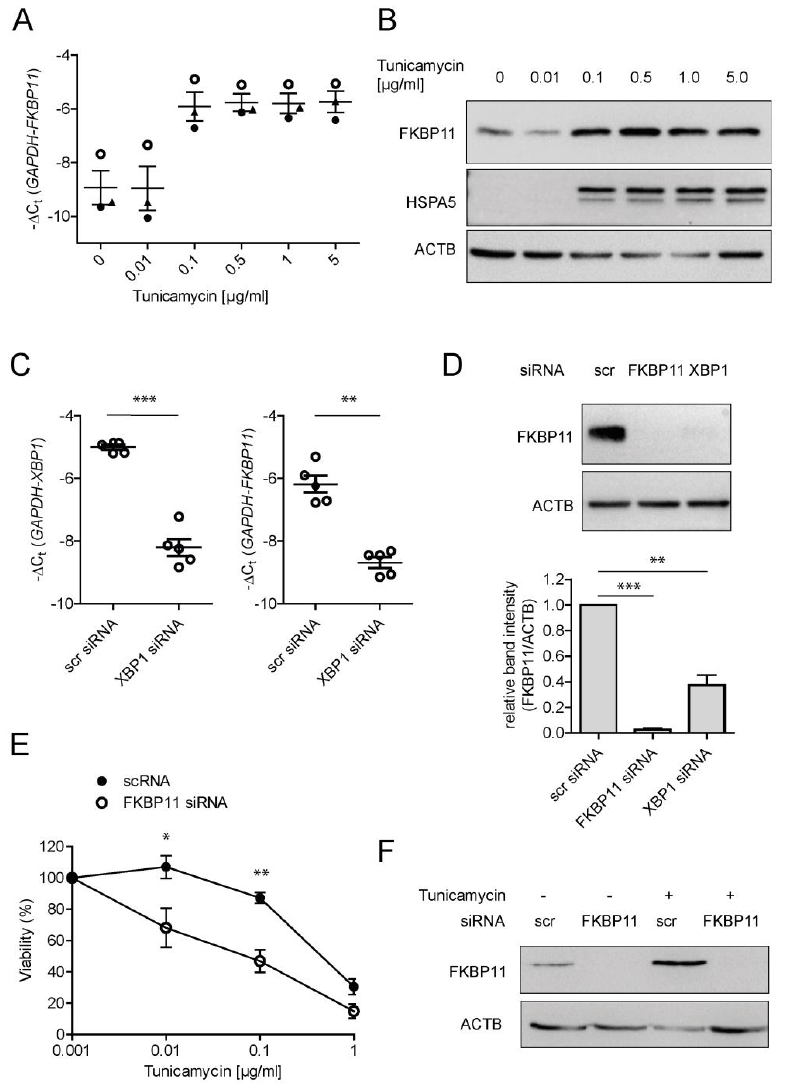
Figure 4. FKBP11 is induced by ER stress in an XBP1-dependent manner and protects from ER- stress induced cell death. ( A , B ) Treatment of A549 with the synthetic ER stress inducer tunicamycin led to a dose-dependent increase of FKBP11 expression both on transcript ( A ) and on protein level ( B ). Upregulation of the ER chaperone HSPA5 confirmed induction of ER stress. ACTB = β -actin as loading control. ( C ) Knockdown of XBP1 in A549 cells treated with 0.1 µg/mL tunicamycin was efficient as assessed by qRT-PCR (left, p = 0.0007, paired t -test) and led to a drastic decrease of FKBP11 transcript (right, p = 0.0026, paired t -test). ( D ) Knockdown of XBP1 equally led to loss of FKBP11 protein ( p = 0.0014, paired t -test). This result is shown in comparison to FKBP11 knockdown under similar conditions ( p < 0.0001, paired t -test); top panel, representative Western Blot; bottom panel corresponding densitometric analysis). ( E ) Combining FKBP11 knockdown with different concentrations of tunicamycin ranging from 1 ng/mL to 1 µ g/mL and assessing cell viability by trypan blue exclusion showed that FKBP11 knockdown leads to higher susceptibility to ER stress- induced cell death (Exact p -values: 0.01 µ g/mL: p = 0.0414; 0.1 µ g/mL: p = 0.0068; paired t -test.) ( F ) Knockdown of FKBP11 in A549 cells was highly efficient in absence and presence of tunicamycin. For ( A , E ) data shown is based on three and four independent experiments, respectively, and given as mean ± SEM. ( B , F ) is representative for three independent experiments. For ( C , D ), data shown is based on five independent experiments and given as mean ± SEM. A paired t -test was used for statistical analysis (* p < 0.05; ** p < 0.01; *** p <